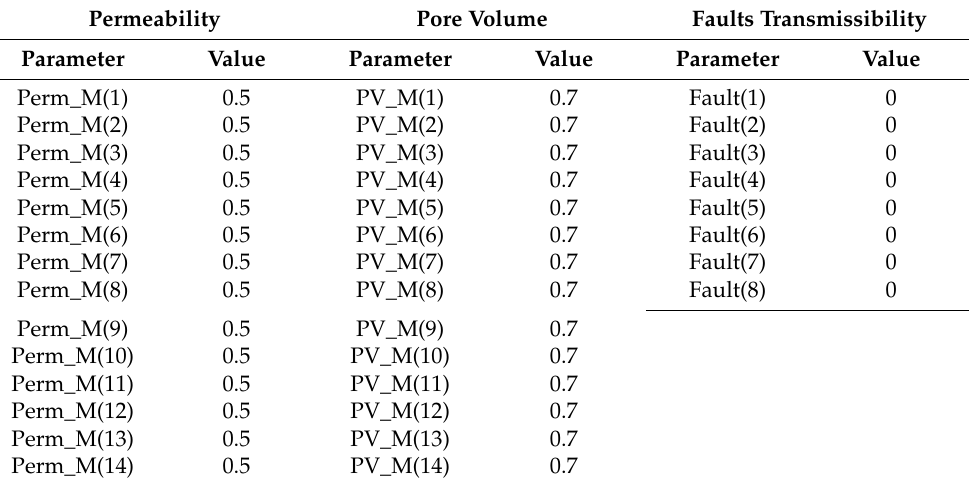
Table 7. The summary of parameters used to generate the first simulation model from Table